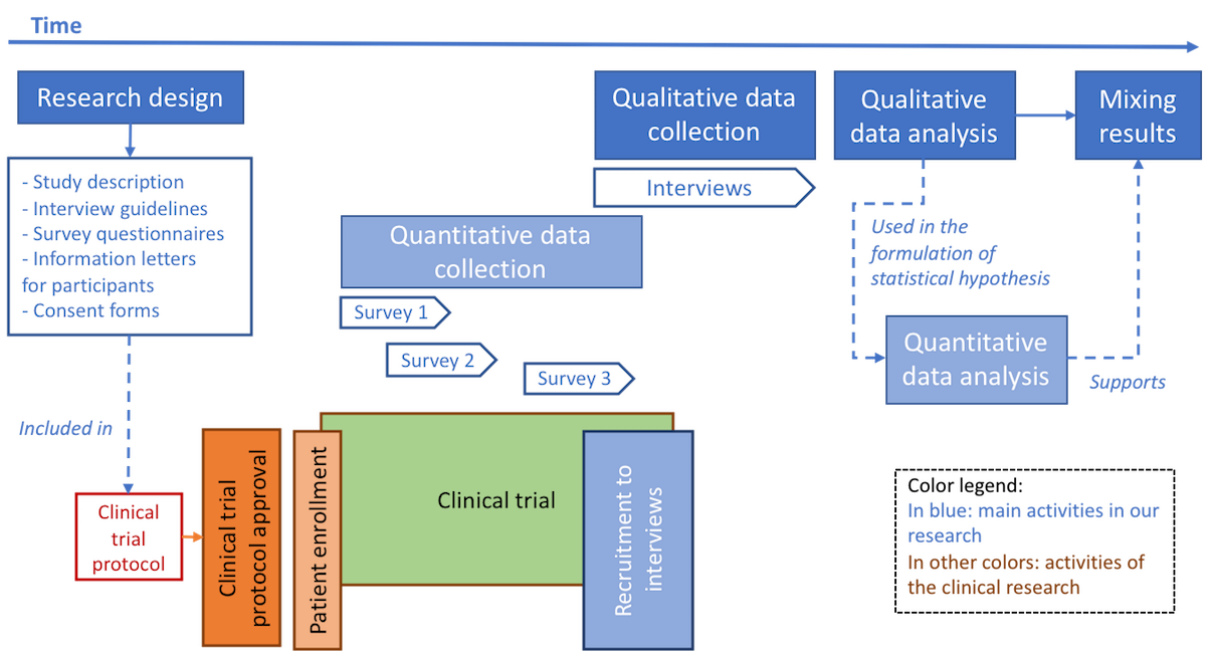
Figure 1. Flowchart of the research